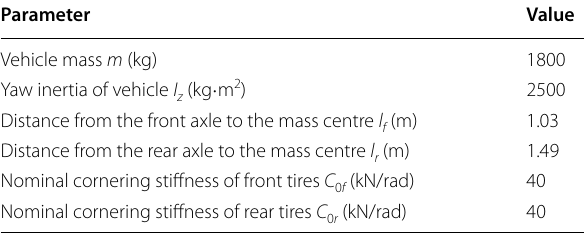
Table 1 Main parameter values of vehicle model